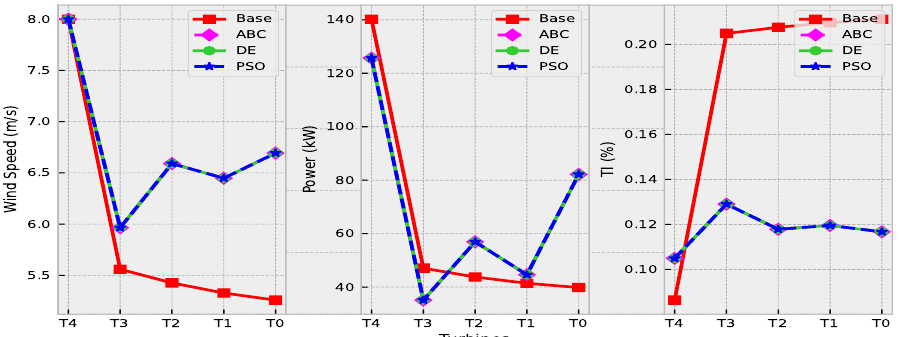
Figure 13. 5 D deployment distance at 8 m/s mean wind